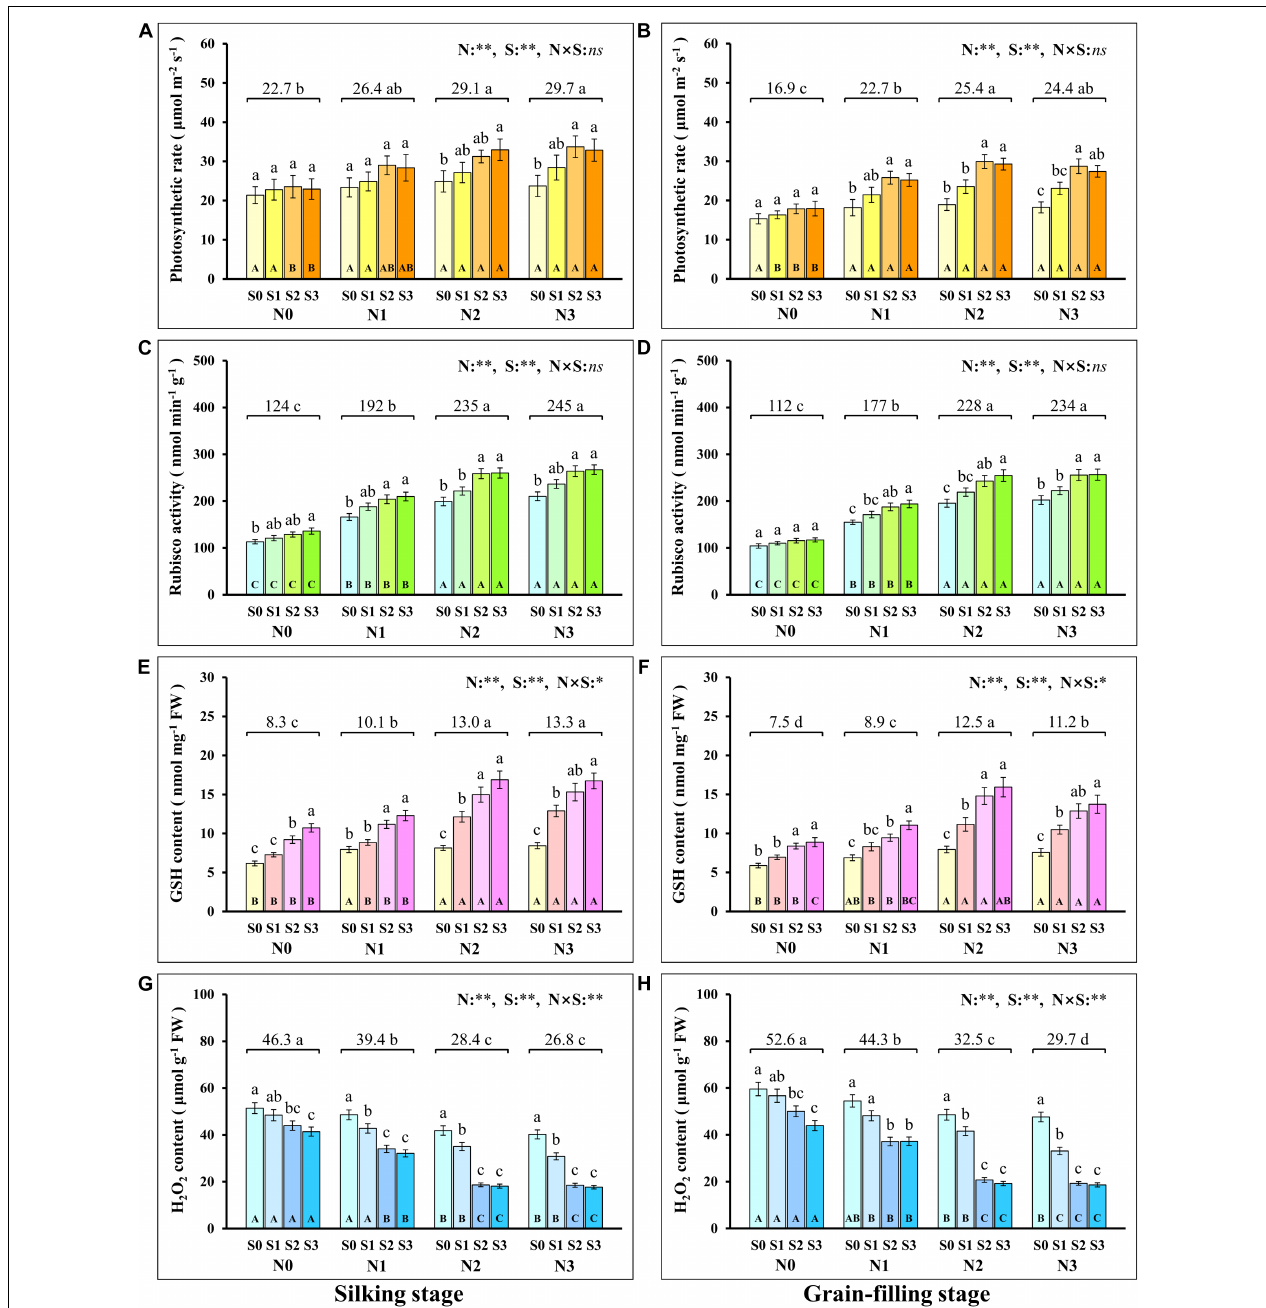
FIGURE 1 | Physiological response during photosynthesis at different N and S rates. The data are the means of four replicates, and the error bars represent the standard deviations. The lowercase letters above the bars indicate the significant differences between the different S rates at the same N level, and the different uppercase letters in the bars indicate the significant differences between the different N rates at the same S level. The number on the horizontal line above each group of bars indicates the average value of the corresponding indicator represented by the ordinate axis at different N levels, and the lowercase letters after the number indicate that the indicator has significant differences at different N levels. The variance analysis used two-way ANOVA ( ∗∗ P < 0.01, ∗ P < 0.05, ns P > 0.05). Response of photosynthetic rate (A,B) , Rubisco activity (C,D) , GSH (E,F) , H 2 O 2 content (G,H) in silking and grain-filling stage to different N and S rates.